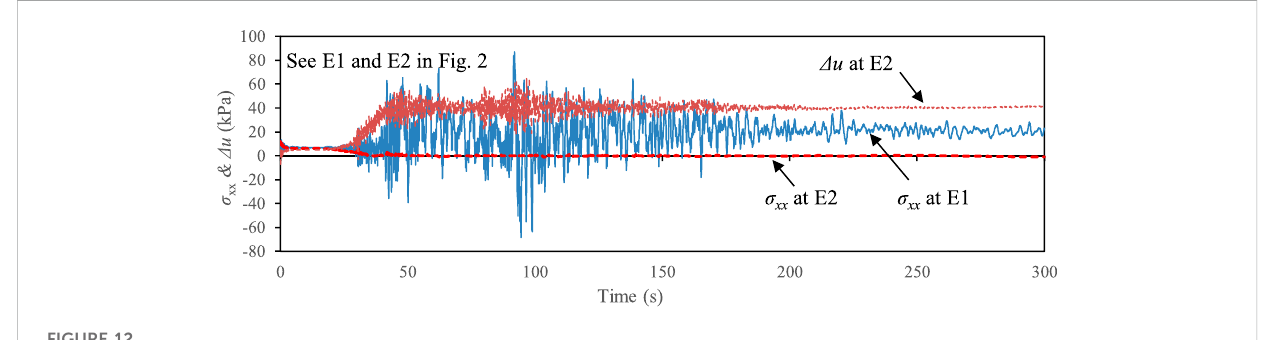
FIGURE 12 Time histories of horizontal stress ( σ xx ) and excess pore water pressure ( Δ u ) at typical points behind the A1 abutment (see E1 and E2 in Figure 2) (Case